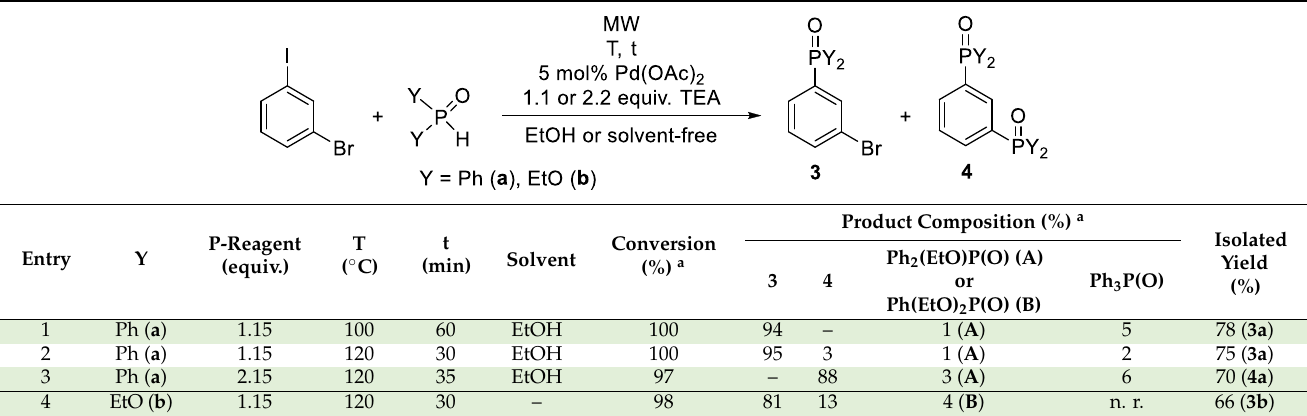
Table 5. P–C coupling reactions of 3-bromo-iodobenzene. Table 5. P – C coupling reactions of 3-bromo-iodobenzene.